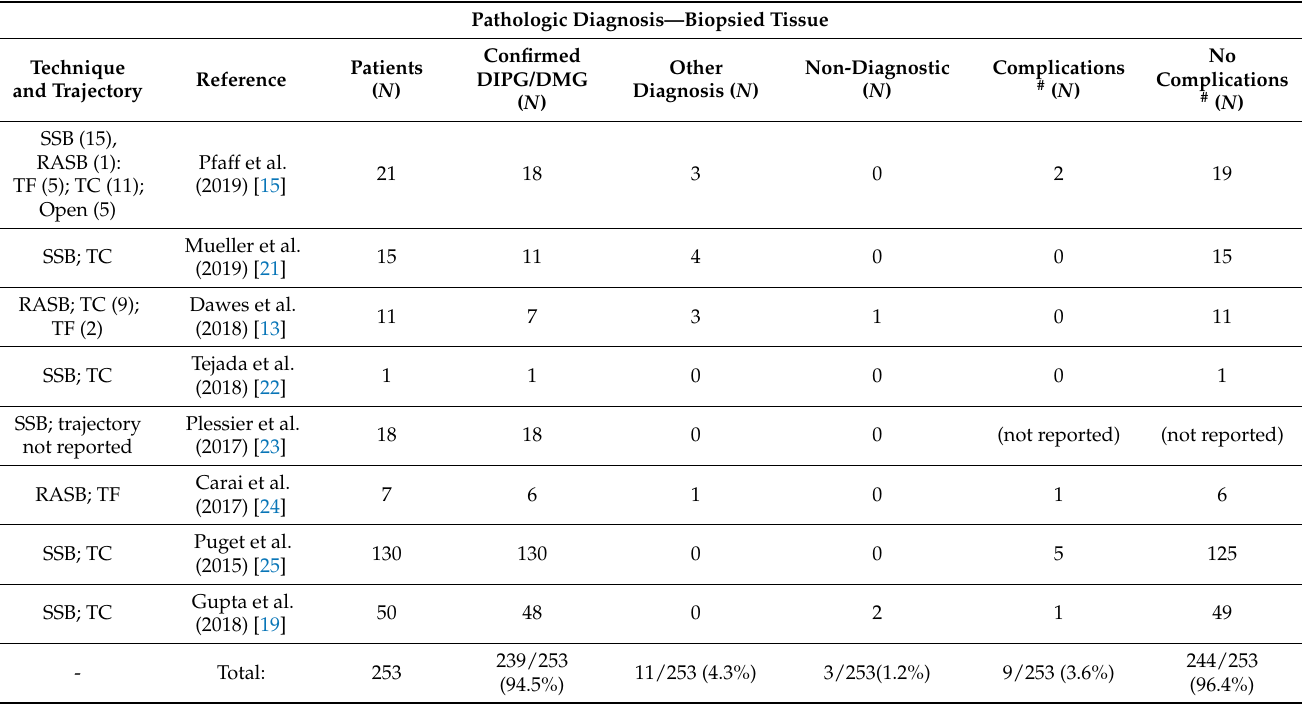
Table 1. Surgical biopsy for patients with H3K27M-mutant diffuse midline glioma. Recent clinical studies and trials uti- lizing surgical biopsy for patients with H3K27M-mutant diffuse midline glioma. Pathologic Diagnosis—Biopsied Tissue Technique and Trajec-